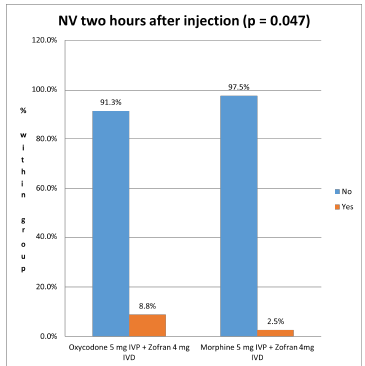
Figure 3. Nausea and vomiting incidence two hours after